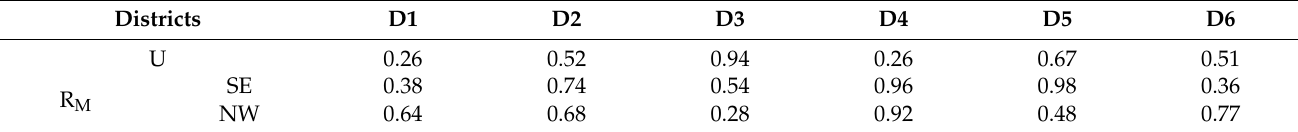
Table 15. The data of the average wind speed ratio and building